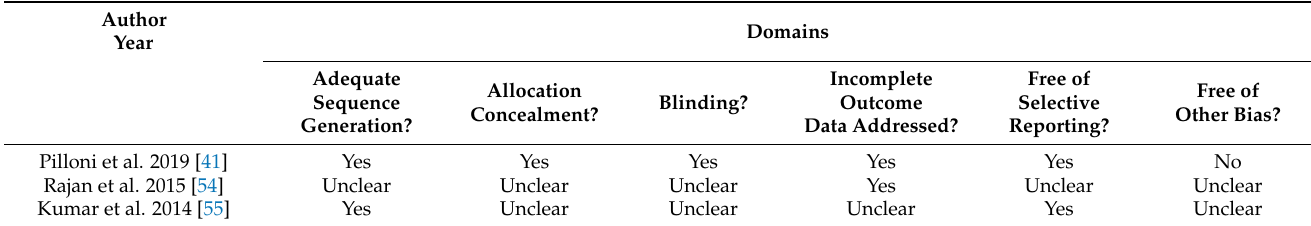
Table 4. Summary of risk of bias of included RCTs (ROB